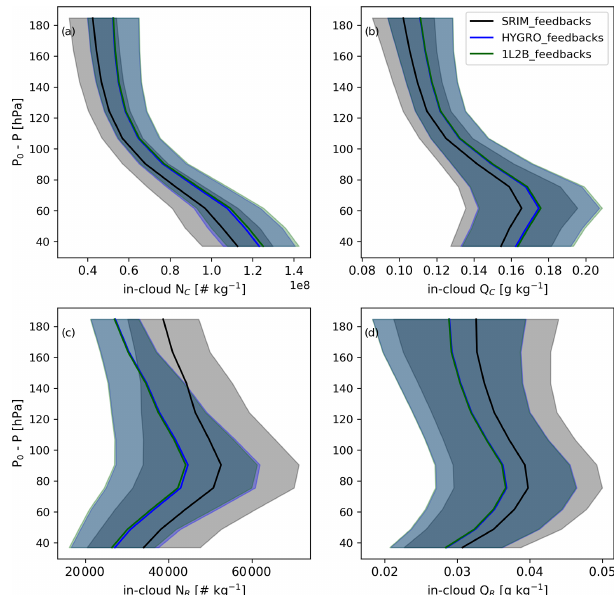
Figure 8. Vertical distribution of temporally and horizontally av- eraged cloud droplet number mixing ratios ( N C , a ), cloud water mixing ratios ( Q C , b ), raindrop number mixing ratios ( N R , c ), and rainwater mixing ratios ( Q R , d ) in the SRIM_feedback, HY- GRO_feedback, and 1L2B_feedback simulations. The shading in- dicates 1 temporal standard deviation about the